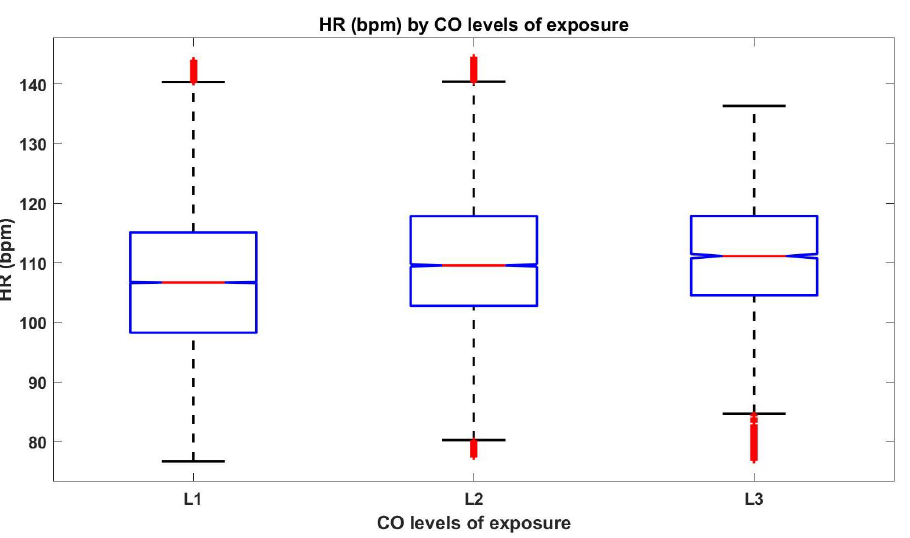
Figure 6. The box plots for HR data of the three FFs considered in this study, per CO exposure level. Figure 6 also points out, with 95% confidence, that the true HR medians of the